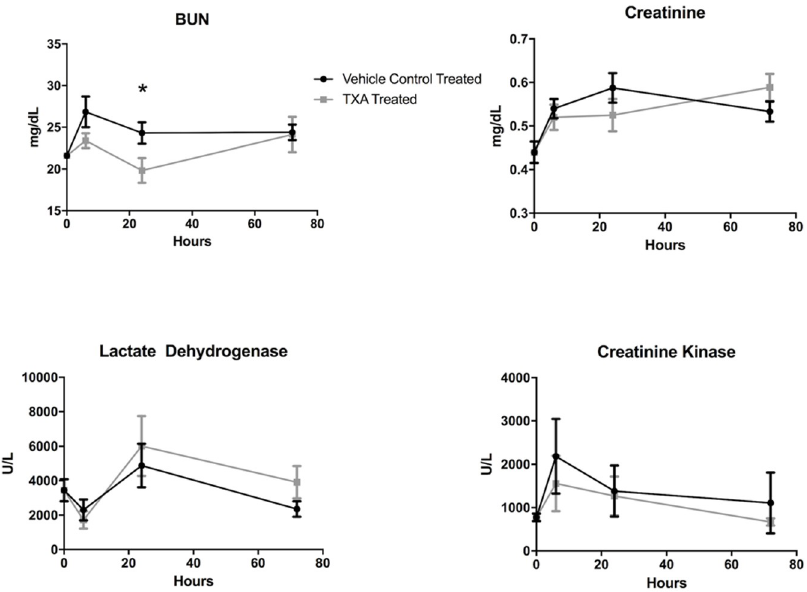
Fig 3. Serum markers of end-organ damage in rats subjected to controlled hemorrhagic shock and resuscitation, vehicle control (normal saline) treated vs. tranexamic acid (TXA) treated, 300mg/kg ( � p < 0.05, error bars = SEM).